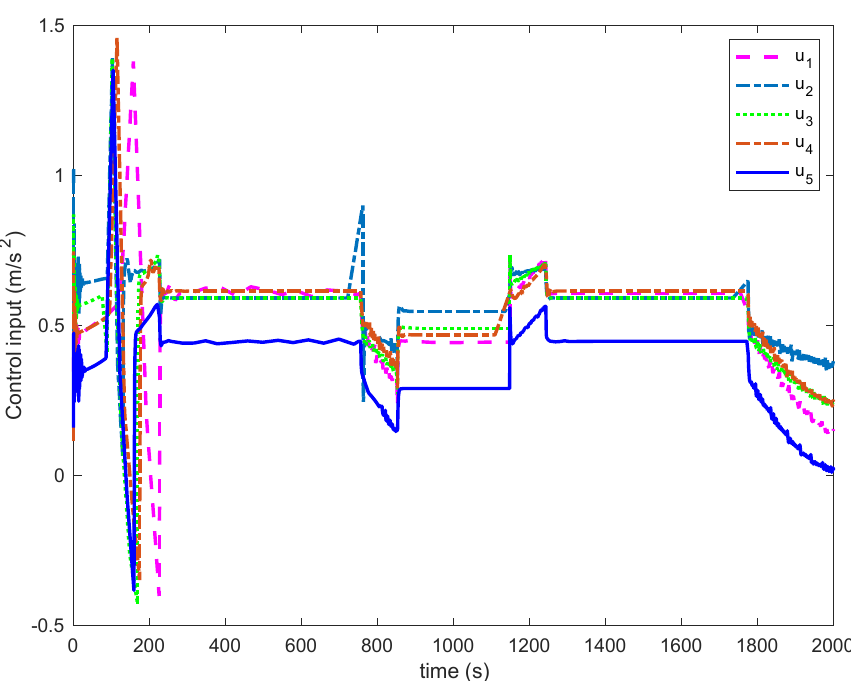
Figure 6. Control input of each train.